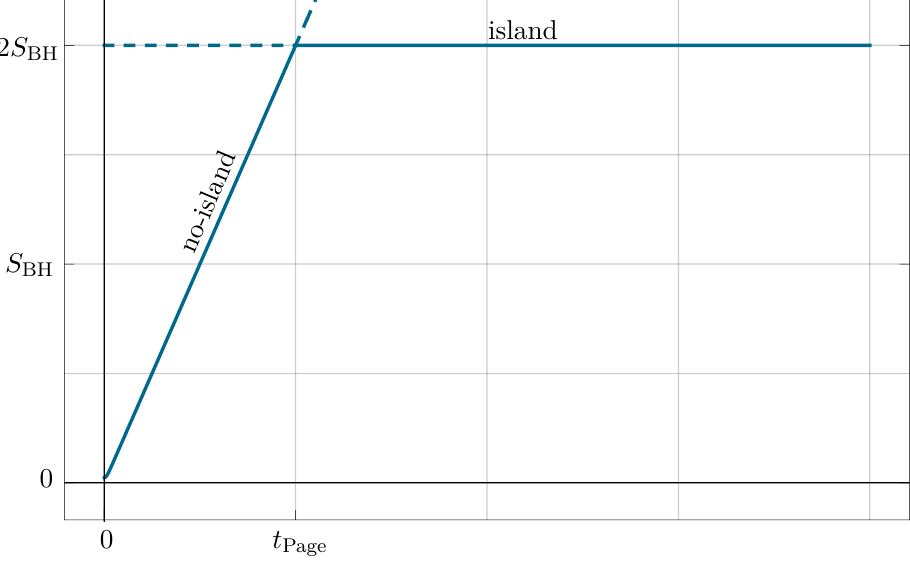
Figure 4 . Page curve for the eternal RST black hole with t Page = 6 S BH =c . The graph